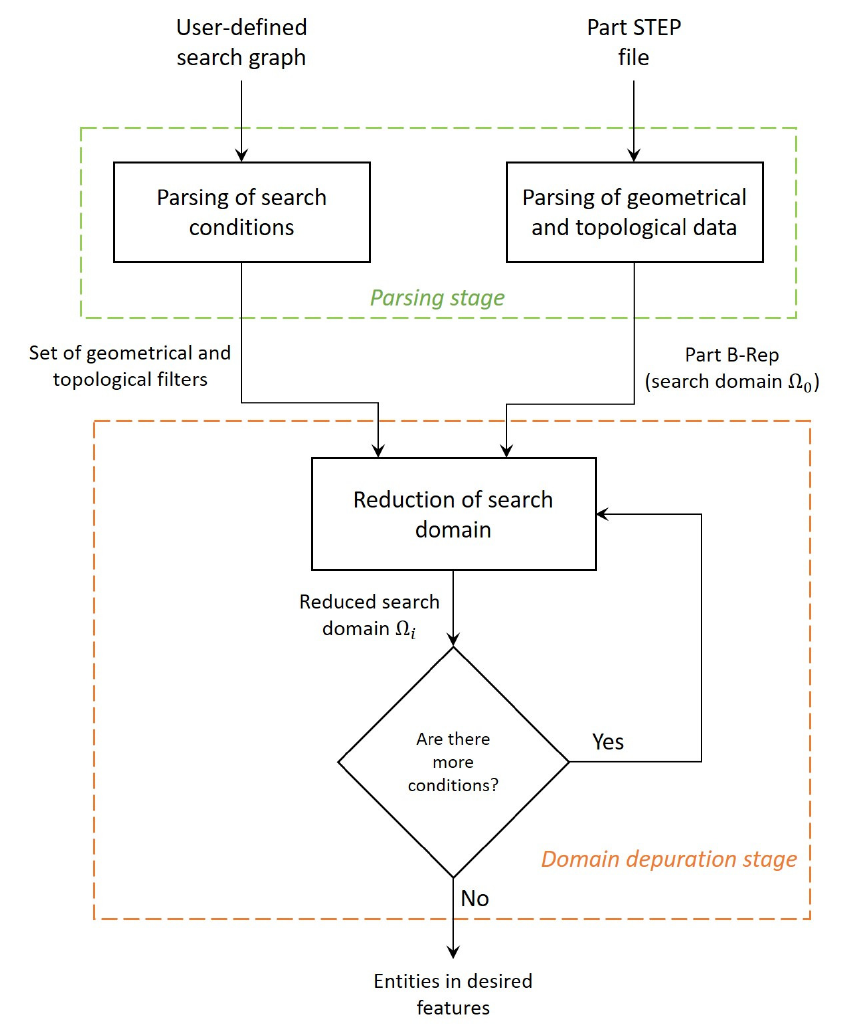
Figure 4. Original flowchart of recognition process (adapted from [2]).